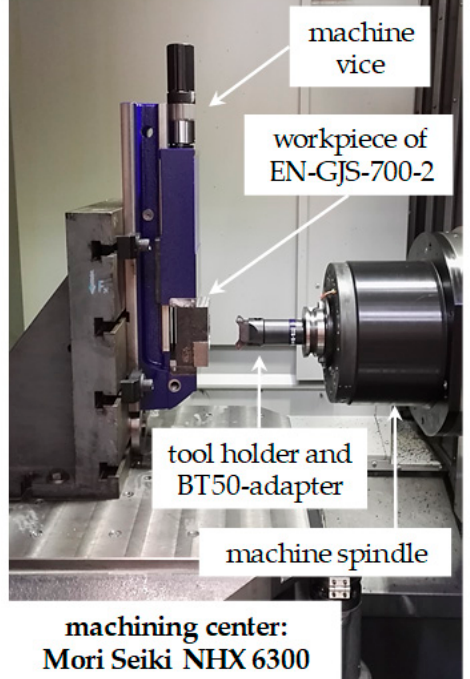
Figure 7. Setup for series-production related cutting tests.